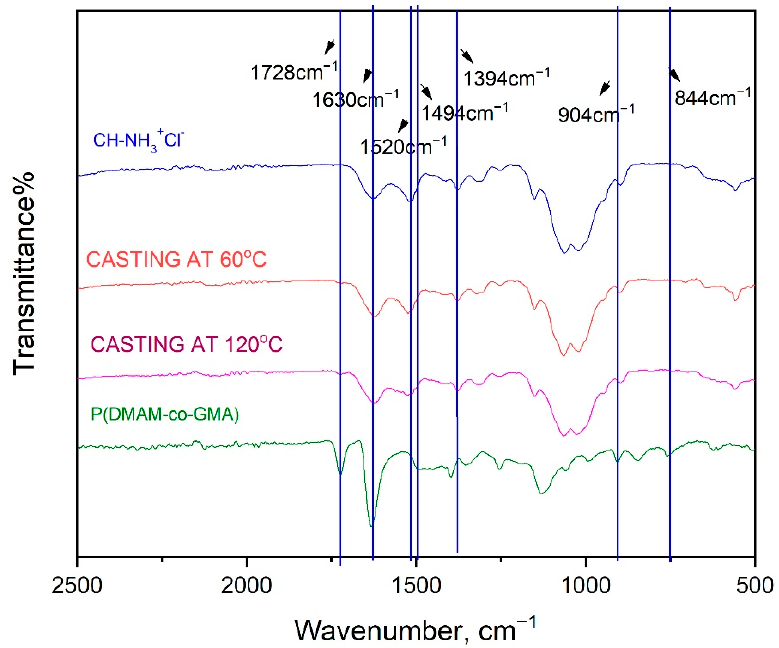
Figure 4. ATR-FTIR spectra in the 500–2500 cm − 1 region of P(DMAM-co-GMA), Ch-NH 3+ Cl − and the membrane Ch-NH 3+ Cl − /P(DMAM- GMA) 9:1 after thermal treatment at 60 °C and 120 °C.